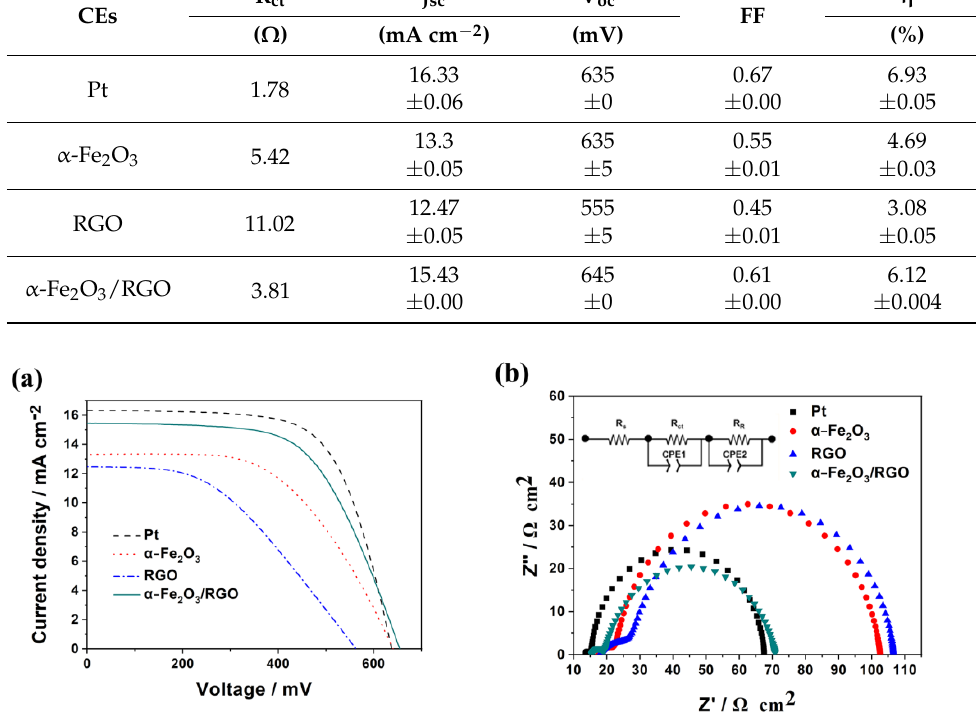
Figure 7. ( a ) Photocurrent density–voltage characteristics and ( b ) Nyquist plots of DSSCs with α -Fe 2 O 3 /RGO, α -Fe 2 O 3 , RGO, and Pt CEs measured at AM 1.5 G illumination (100 mW cm − 2 ). The inset in ( b ) is the equivalent circuit of the DSSCs. Table 1. PCE performances and EIS parameters of the DSSCs with different CEs.